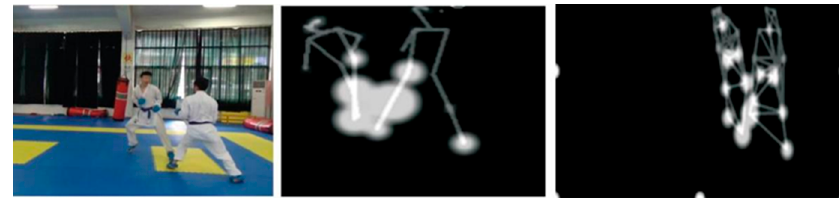
Figure 11. Comparison of feature representation between the ST-GCN and our algorithm. White circles indicate the relevance of features. The larger the circle, the stronger the relevance of a joint point to a certain action; the more circles, the more related feature points extracted from a certain action.